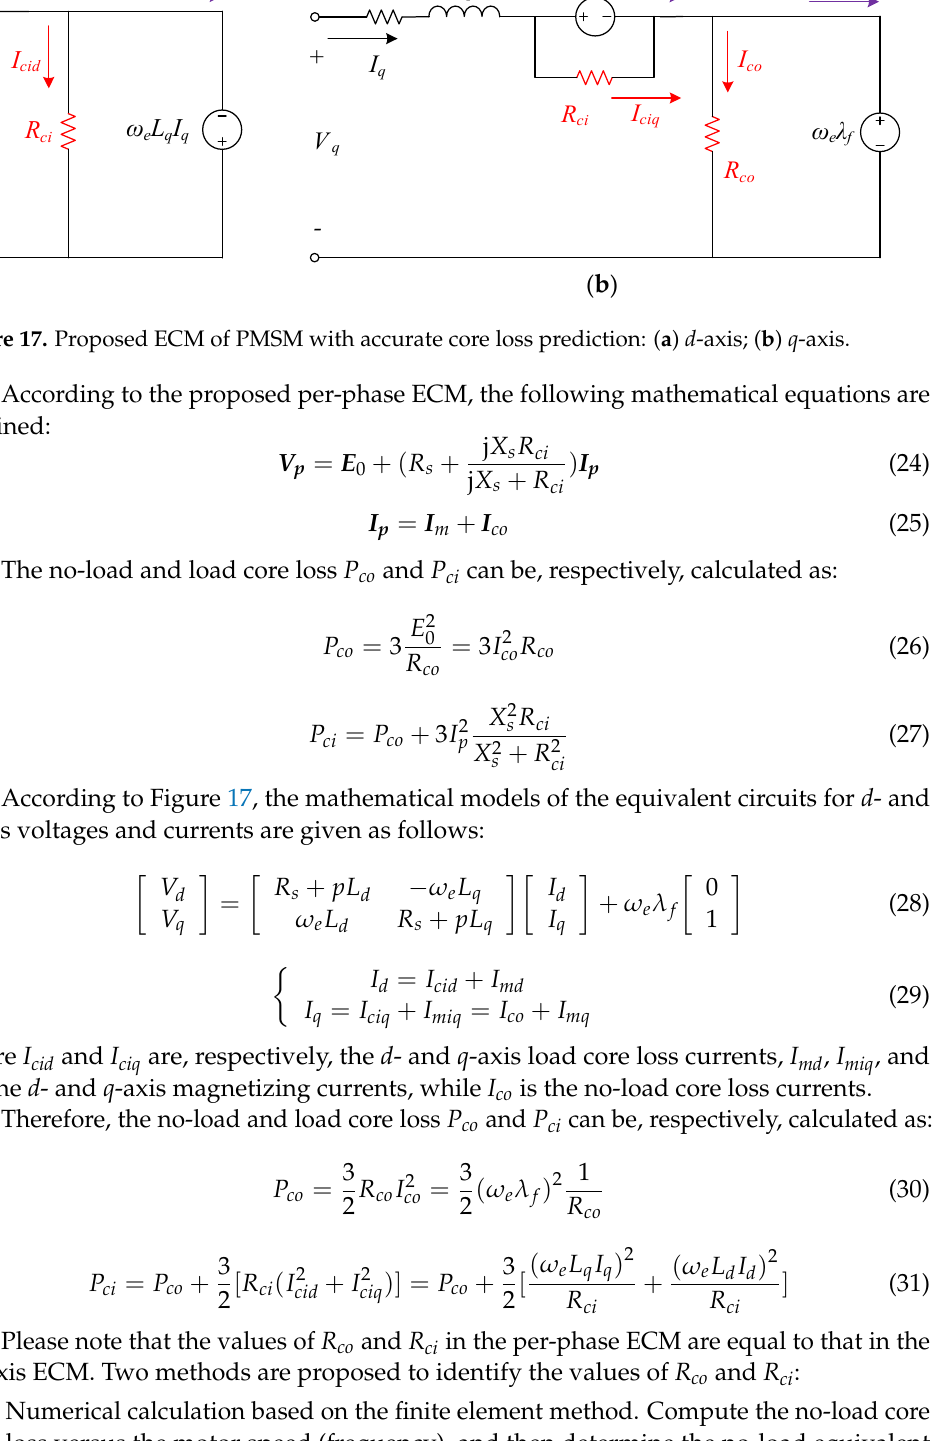
core loss resistance R co , as a function of the motor speed (frequency) via data